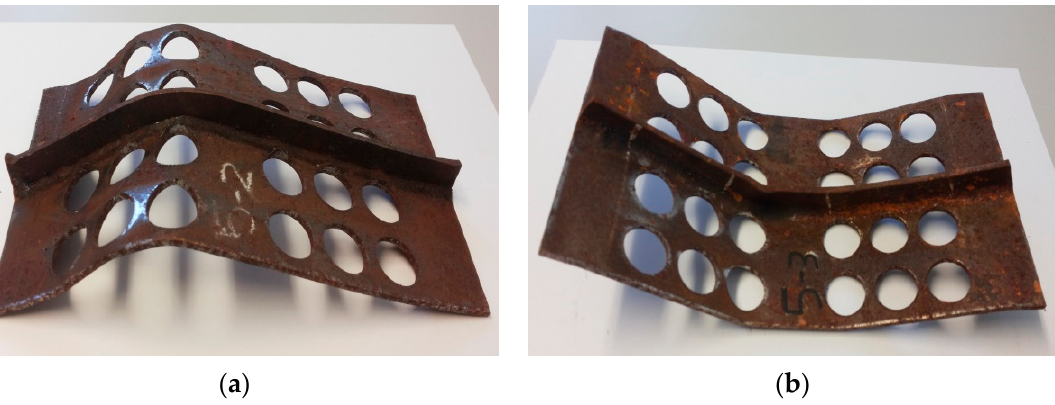
Figure 8. Post-collapse deformed shape for n = 24 and DoO = 28.30%, SP-NS5-2 ( a ) and SP-NS5-3 ( b ).